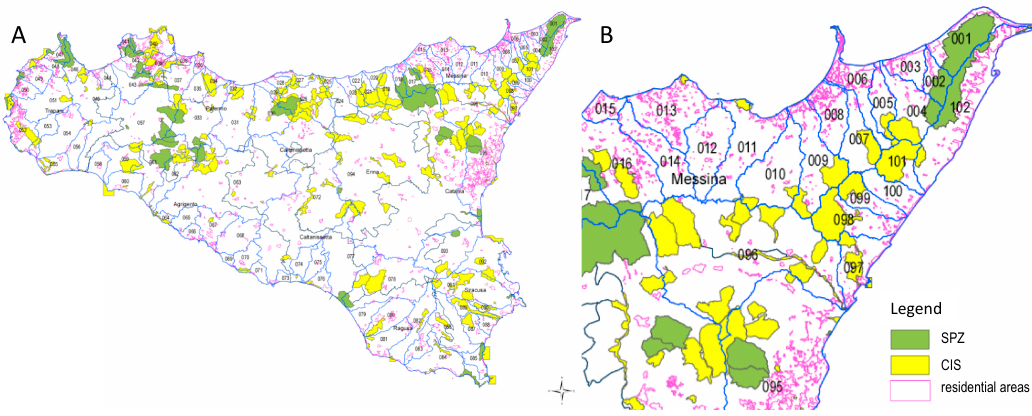
Figure 10. Sites of Community Importance and Special Protection Zones in Sicily ( A ) and in the Fiumedinisi river basin area ( B ).